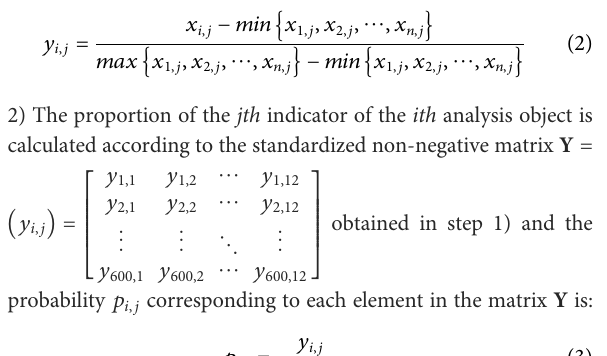
FIGURE 2 Gravel distribution map.